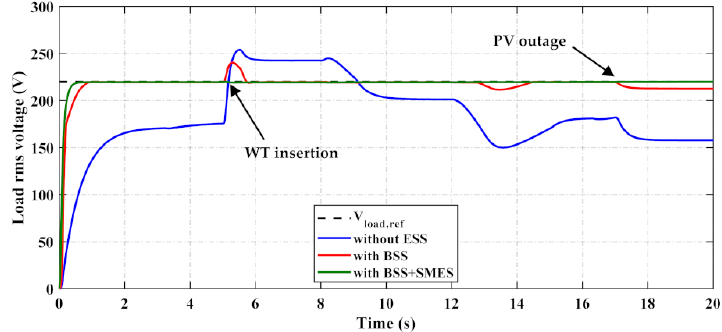
Figure 13. Load rms voltage during the three examined cases.